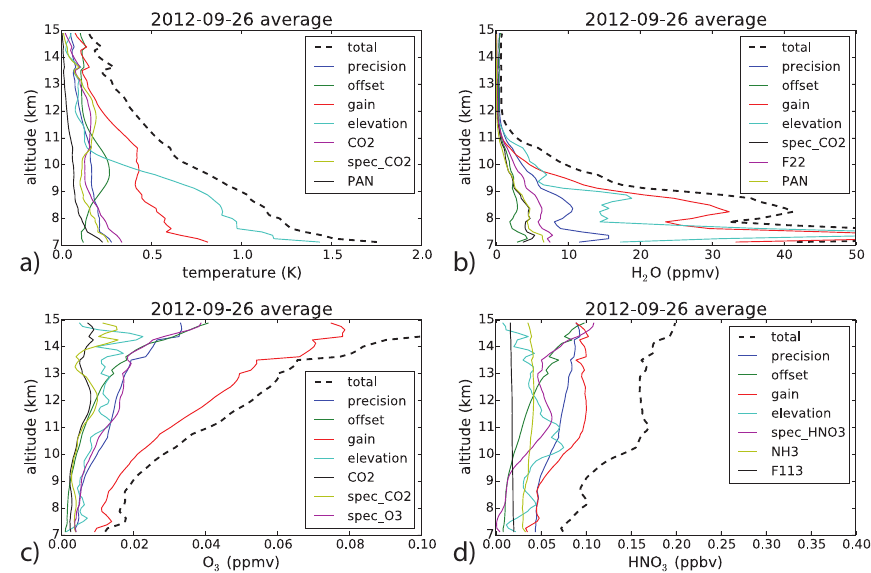
Figure 4. Total error and major error sources for the four primary targets temperature (a) , H 2 O (b) , O 3 (c) , and HNO 3 (d) averaged over the profiles of the flight of 26 September 2012. A “spec” prefix notes the error induced by spectral uncertainty of line intensities.